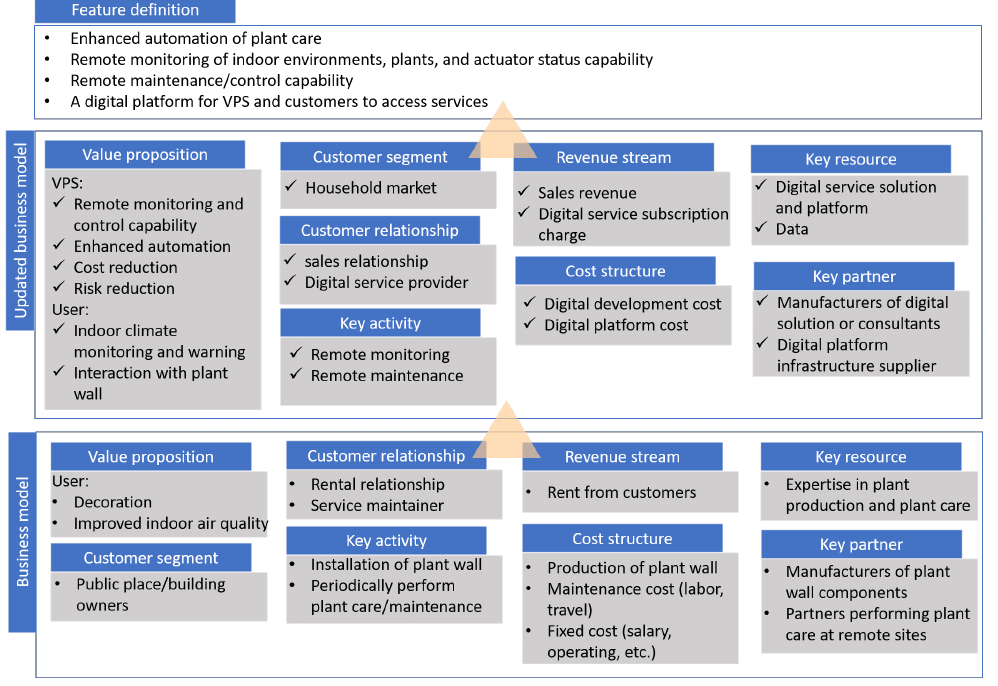
Figure 4. Digital transformation practice for Vertical Plant Systems AB in the business stage. The business model is updated according to the anticipated digital product, and the features of the digital product are defined